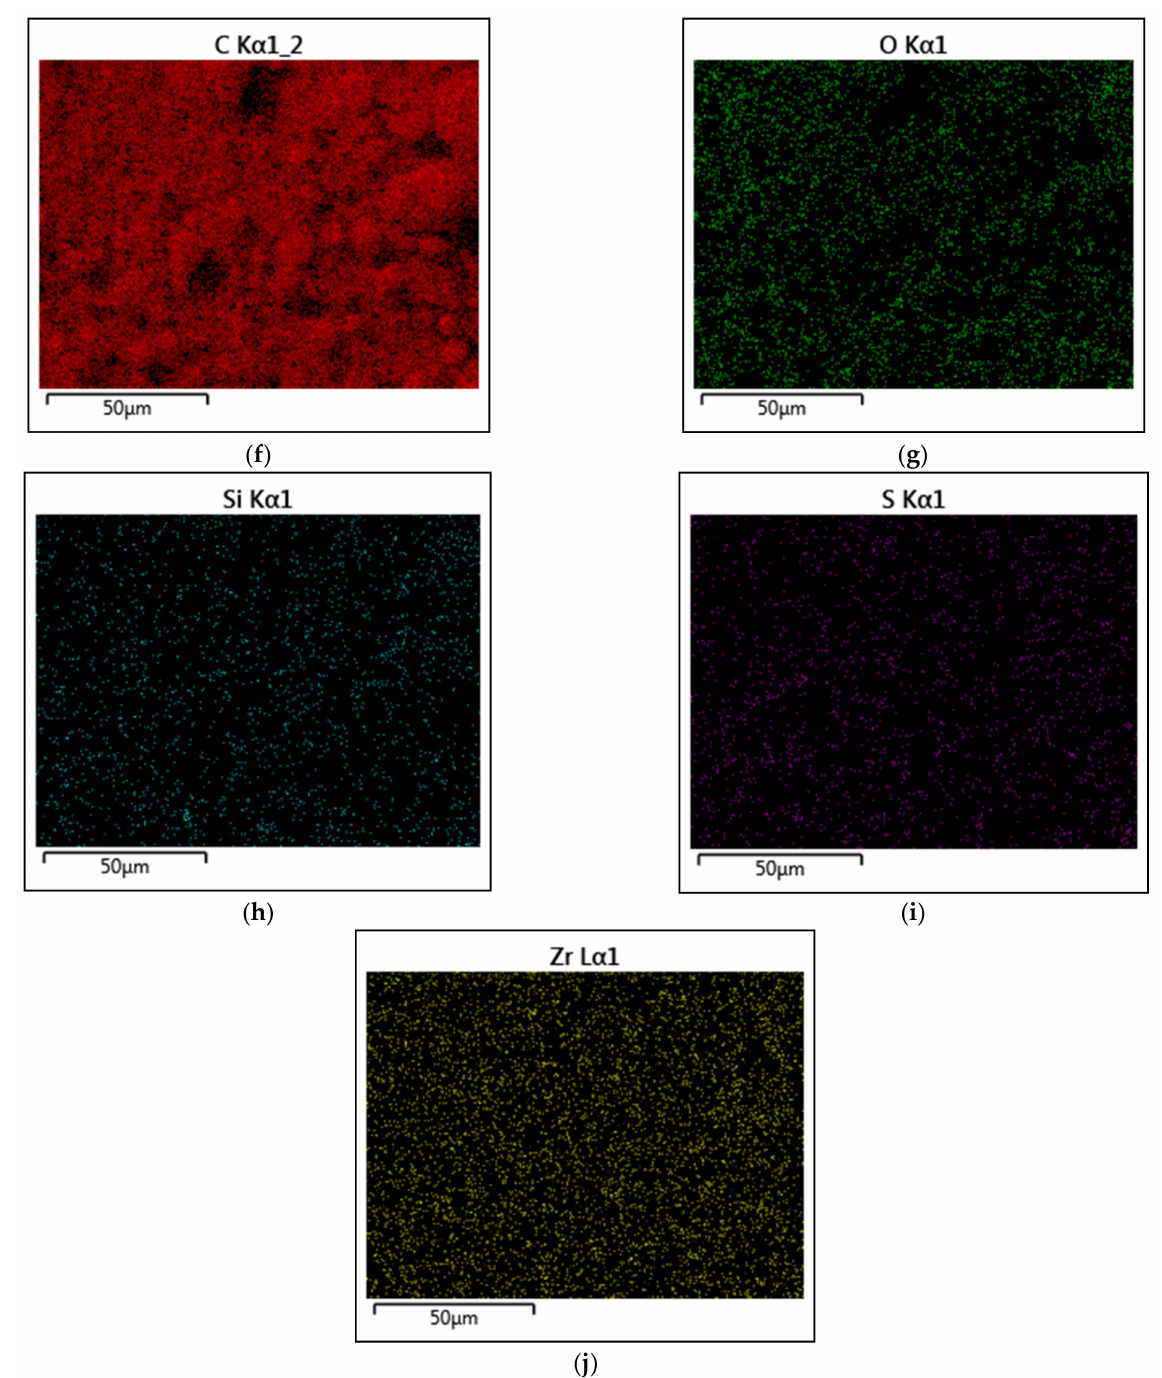
Figure 9. SEM and energy-dispersive X-ray spectroscopy (EDX) mapping analysis of the GNPs; ( a ) SEM microimage at 2 µ m; ( b ) SEM microimage at 5 µ m; ( c ) EDX mapping analysis; ( d ) EDX elemental analysis; ( e ) electron image; ( f ) carbon mapping; ( g ) oxygen mapping; ( h ) silicon mapping; ( i ) sulfur mapping; ( j ) zirconium